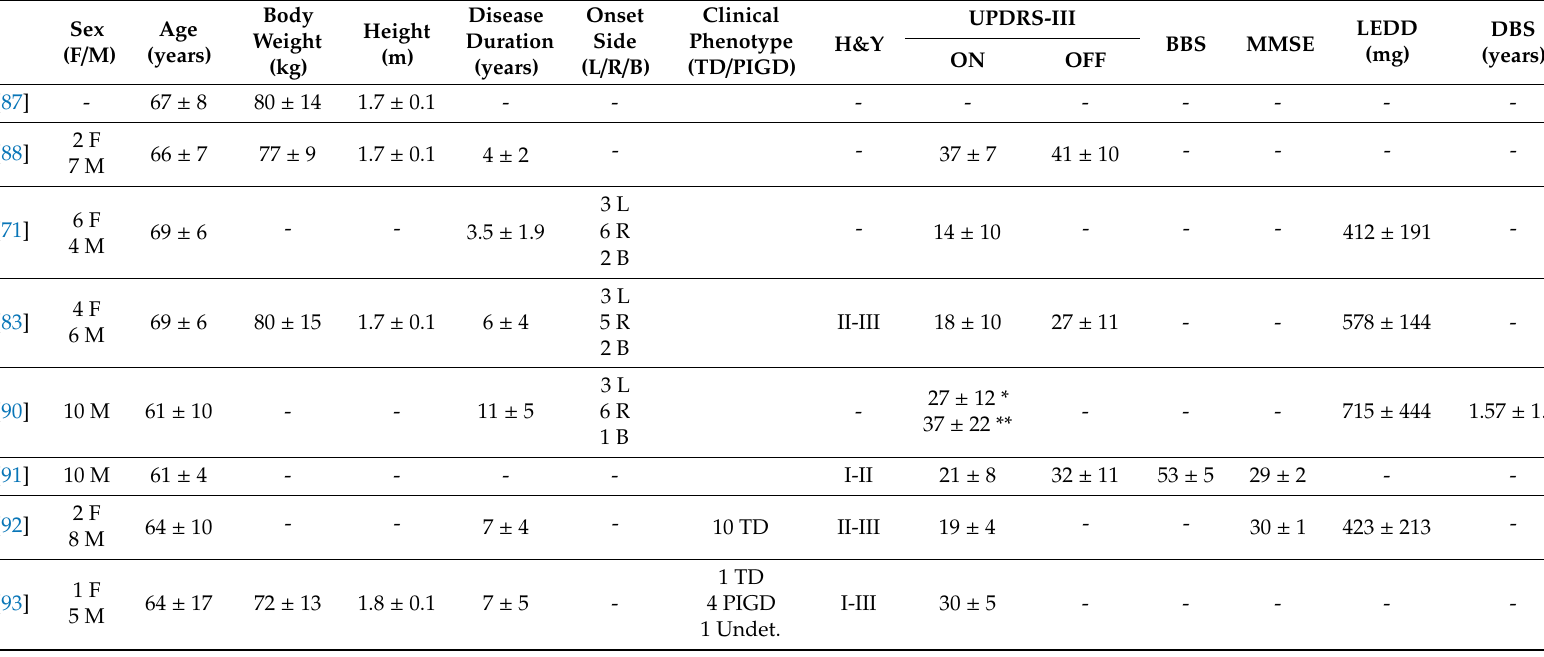
Table 1. Demographic and clinical features of Parkinson’s disease patients in studies investigating muscle